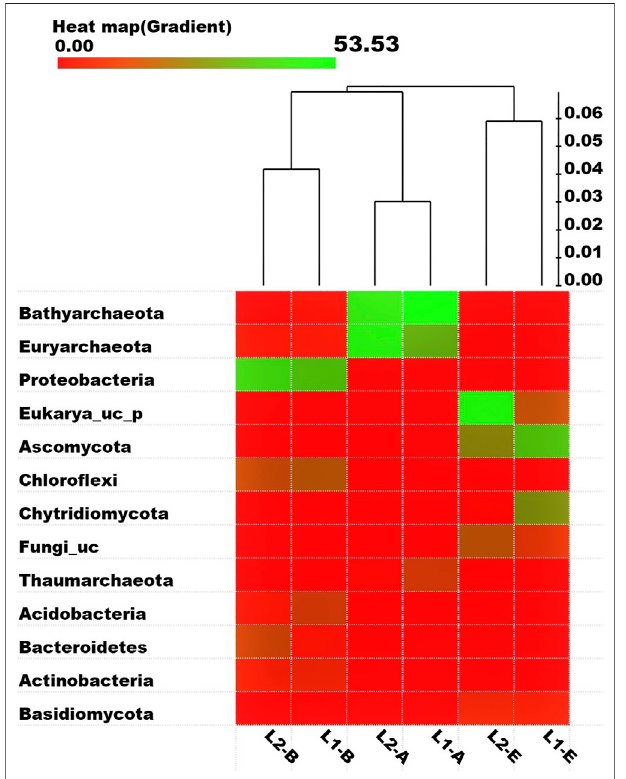
FIGURE 2 | Heat map (gradient) representing the abundance of eight bacterial families, above the cut off (phylotypes that are over 5% from an individual sample). Each taxon and its proportion are represented by a square and relativity of samples based on operational taxonomic units (OTUs) delineated by the OrthoAni scale is shown as a dendrogram. The full green square equals 53.53%.